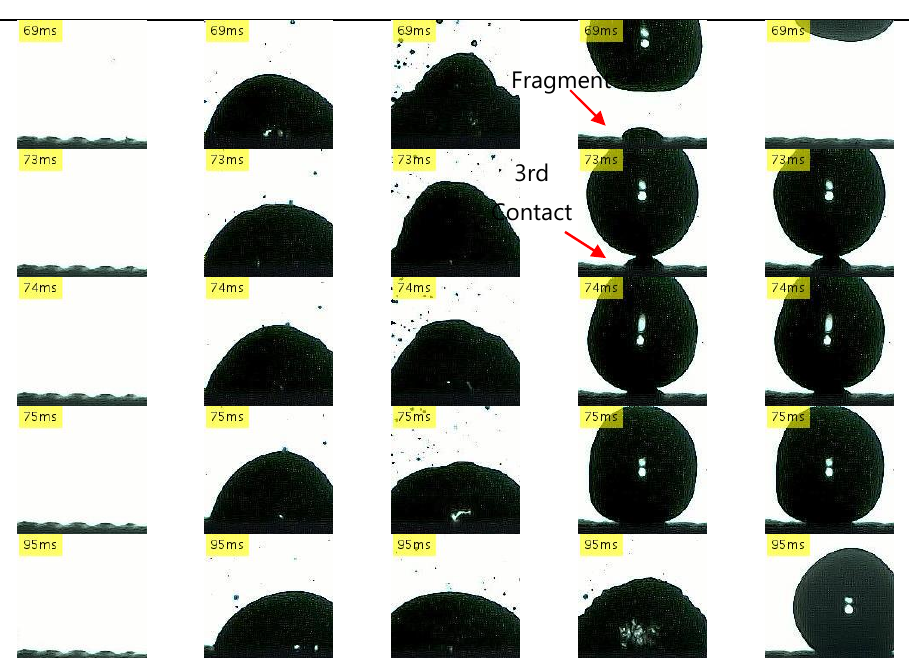
Figure 9. Sequential images of drop impact on #60 mesh surface. Scale bar is 1 mm. When the surface temperature is increased further, the neck is not formed with the first impact ( T s = 367 °C, t = 7–12 ms) but is formed with the second impact ( t = 54–60 ms), and a fragment remains on the mesh ( t = 69 ms). Then, the solid–liquid contact is restored with the third impact ( t = 73–75 ms). These findings indicate that the formation of a neck prevents the droplet from bouncing on the mesh surfaces. Similar behaviors were observed with #120 and #200 mesh surfaces. With #120, a neck was formed at T s = 370 °C and t = 9 ms, and a fragment was formed at t = 10.3 ms. With #200, a neck was formed at T s = 405 °C and t = 10 ms, and a fragment was formed at t = 11 ms.